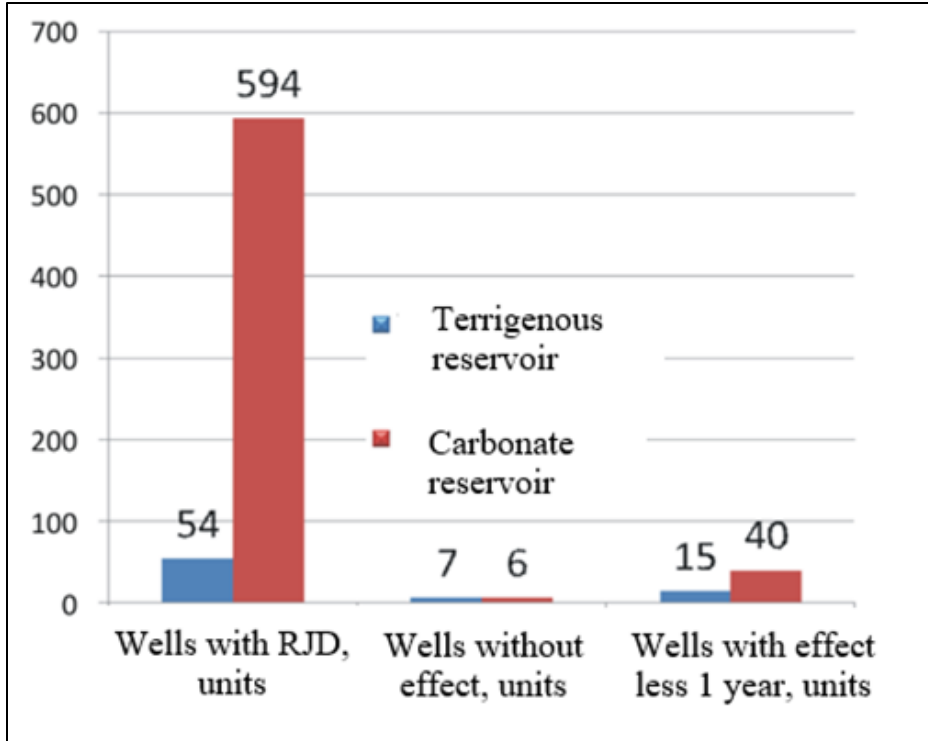
Figure 1. General characteristics of RJD (radial jet drilling) use.